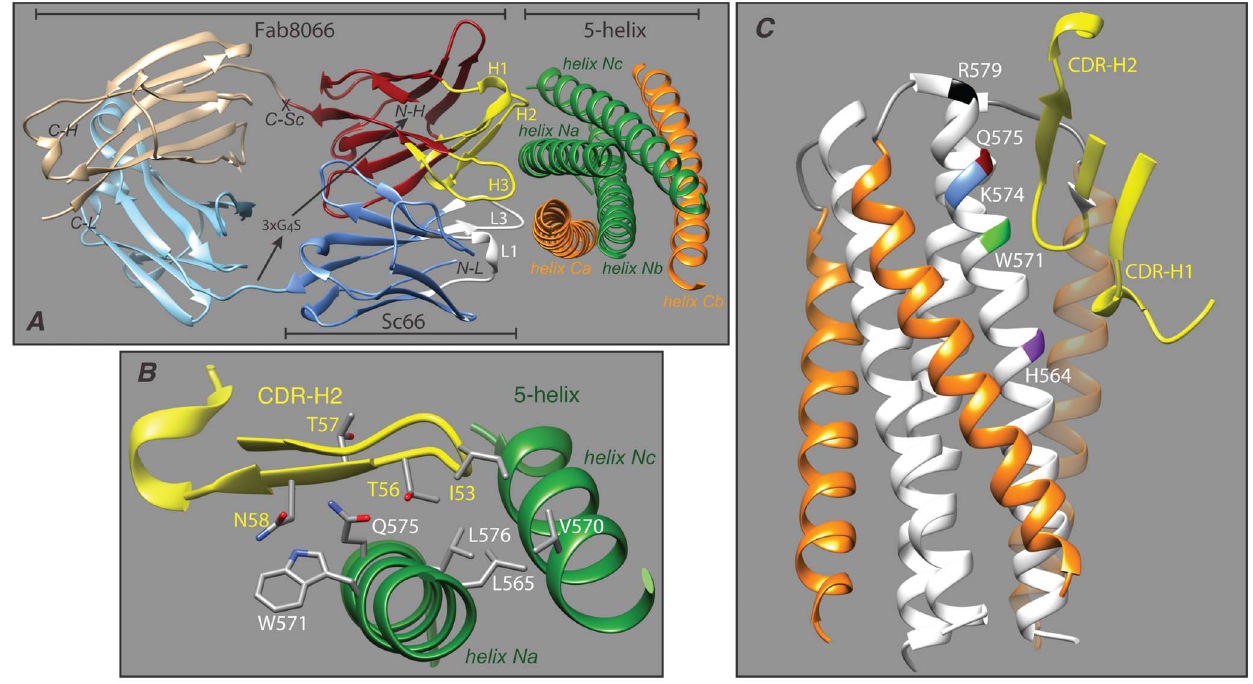
Figure 2. Interaction of Fab8066 with 5-helix and design of the corresponding ScFv Sc66. ( A ) Overall interaction of Fab8066 with 5-helix, ( B ) detailed view of the interaction of the CDR-H2 loop of Fab8066 (yellow) with the two exposed N-HR helices (green) of 5-helix, and ( C ) interaction of the CDR-H1 and CDR-H2 loops of Fab8066 (yellow) with two N-HR helices (white) and one C-HR helix (orange) of 5-helix. The addition of a third C- HR helix (transparent orange) to 5-helix to complete the six-helix bundle would result in steric clash with the CDR-H1 and CDR-H2 loops. Color coding in panels A and B is as follows: N-HR and C-HR helices of 5-helix are shown in green and orange, respectively; the CDR heavy and light chain loops of Fab8066 are shown in yellow and white, respectively; the remainder of the heavy and light variable domains are shown in dark red and blue, respectively; the light and heavy constant domains of Fab8066 are shown in pink and light blue, respectively. In panel C, the three N-HR helices are shown in white and residues mapped by alanine scanning mutagenesis of a six-helix bundle construct as the epitope for binding Fab8066 [20,21,22,23,24,25,26,27], are indicated on one of the N-HR helices (helix Na ). Also shown in panel A is the design employed to construct the corresponding ScFv by linking the C-terminus of the light chain variable domain (blue) to the N-terminus of the heavy-chain variable domain (dark red) via a 15-amino acid linker (3 6 GGGGS). The coordinates are taken from PDB IDs 3MA9 (Fab8066/5-helix complex [35]) and 1SZT (core S trimer [16]).